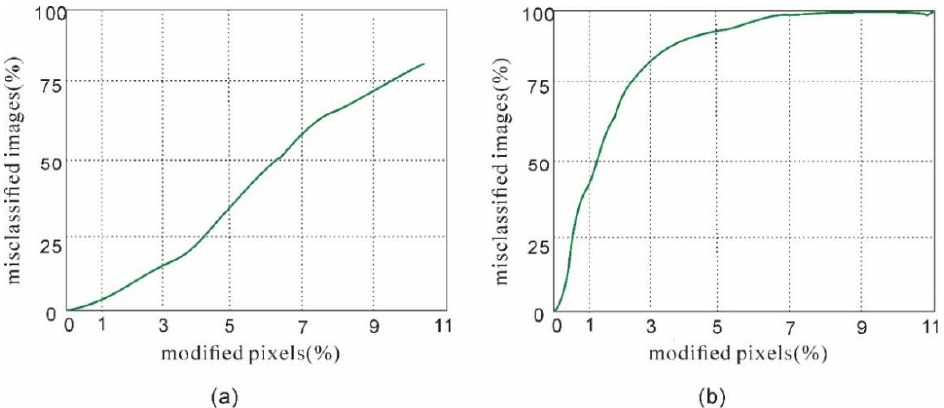
Figure 3. The required modified pixels to fool the classifier into identifying ( a ) real images as fake or ( b ) fake images as real.